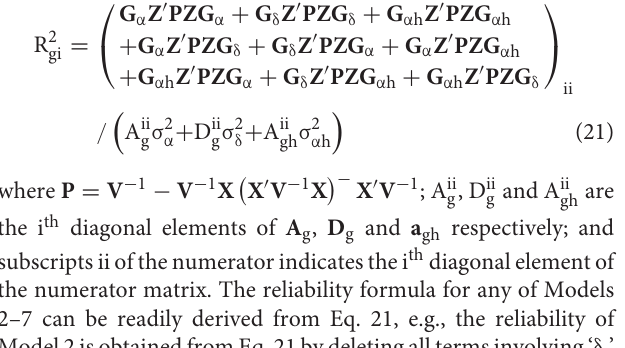
values (e.g., SNP additive values or haplotype additive values) SNP dominance values and haplotype additive values) for